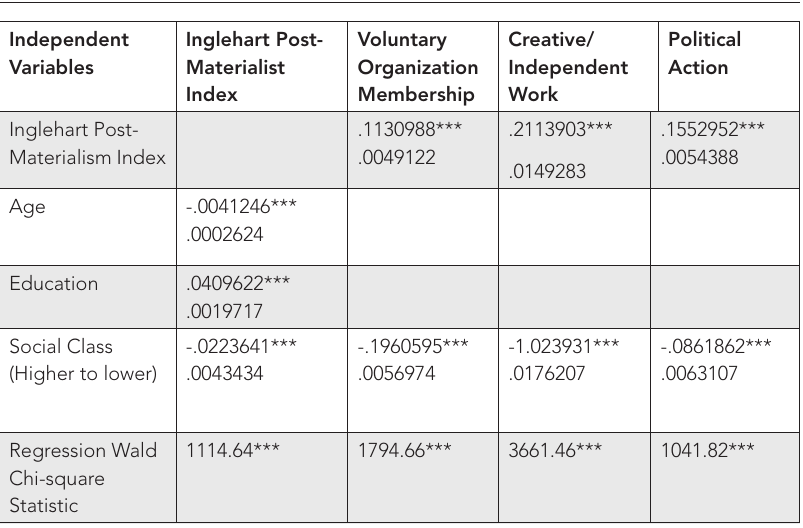
Table 2: Mixed-Effects Post-Materialism and Post-Material Experience Regressions (Coefficients and Standard